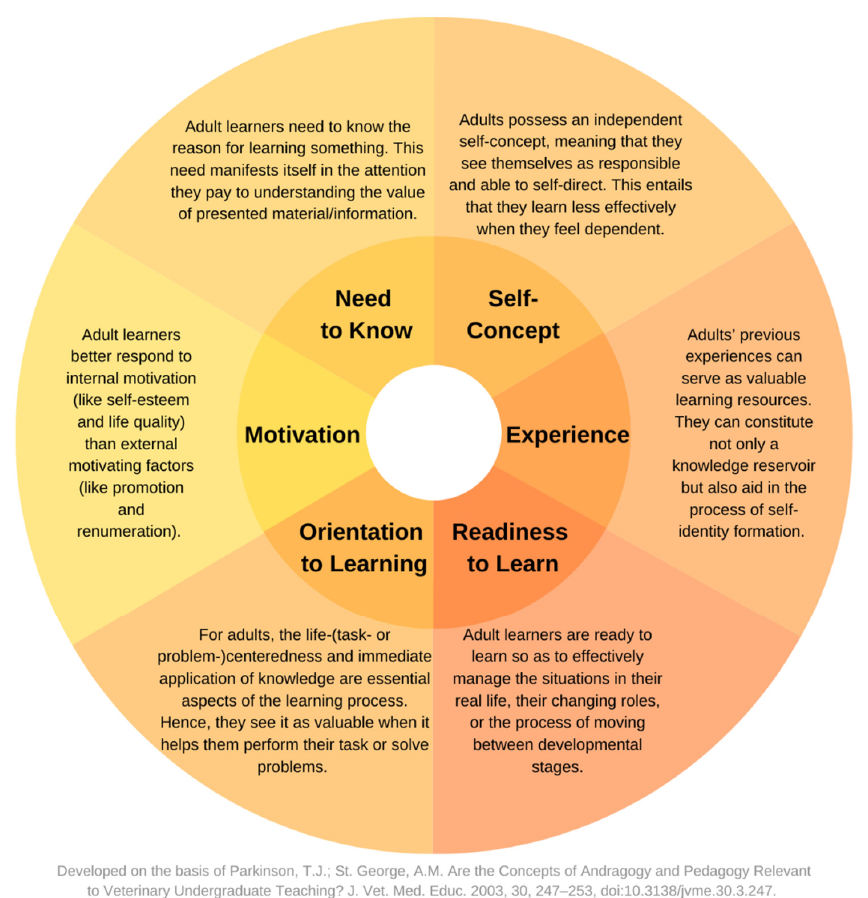
Figure 2. Key assumptions of the andragogy model. Developed on the basis of Parkinson and St. George [29].